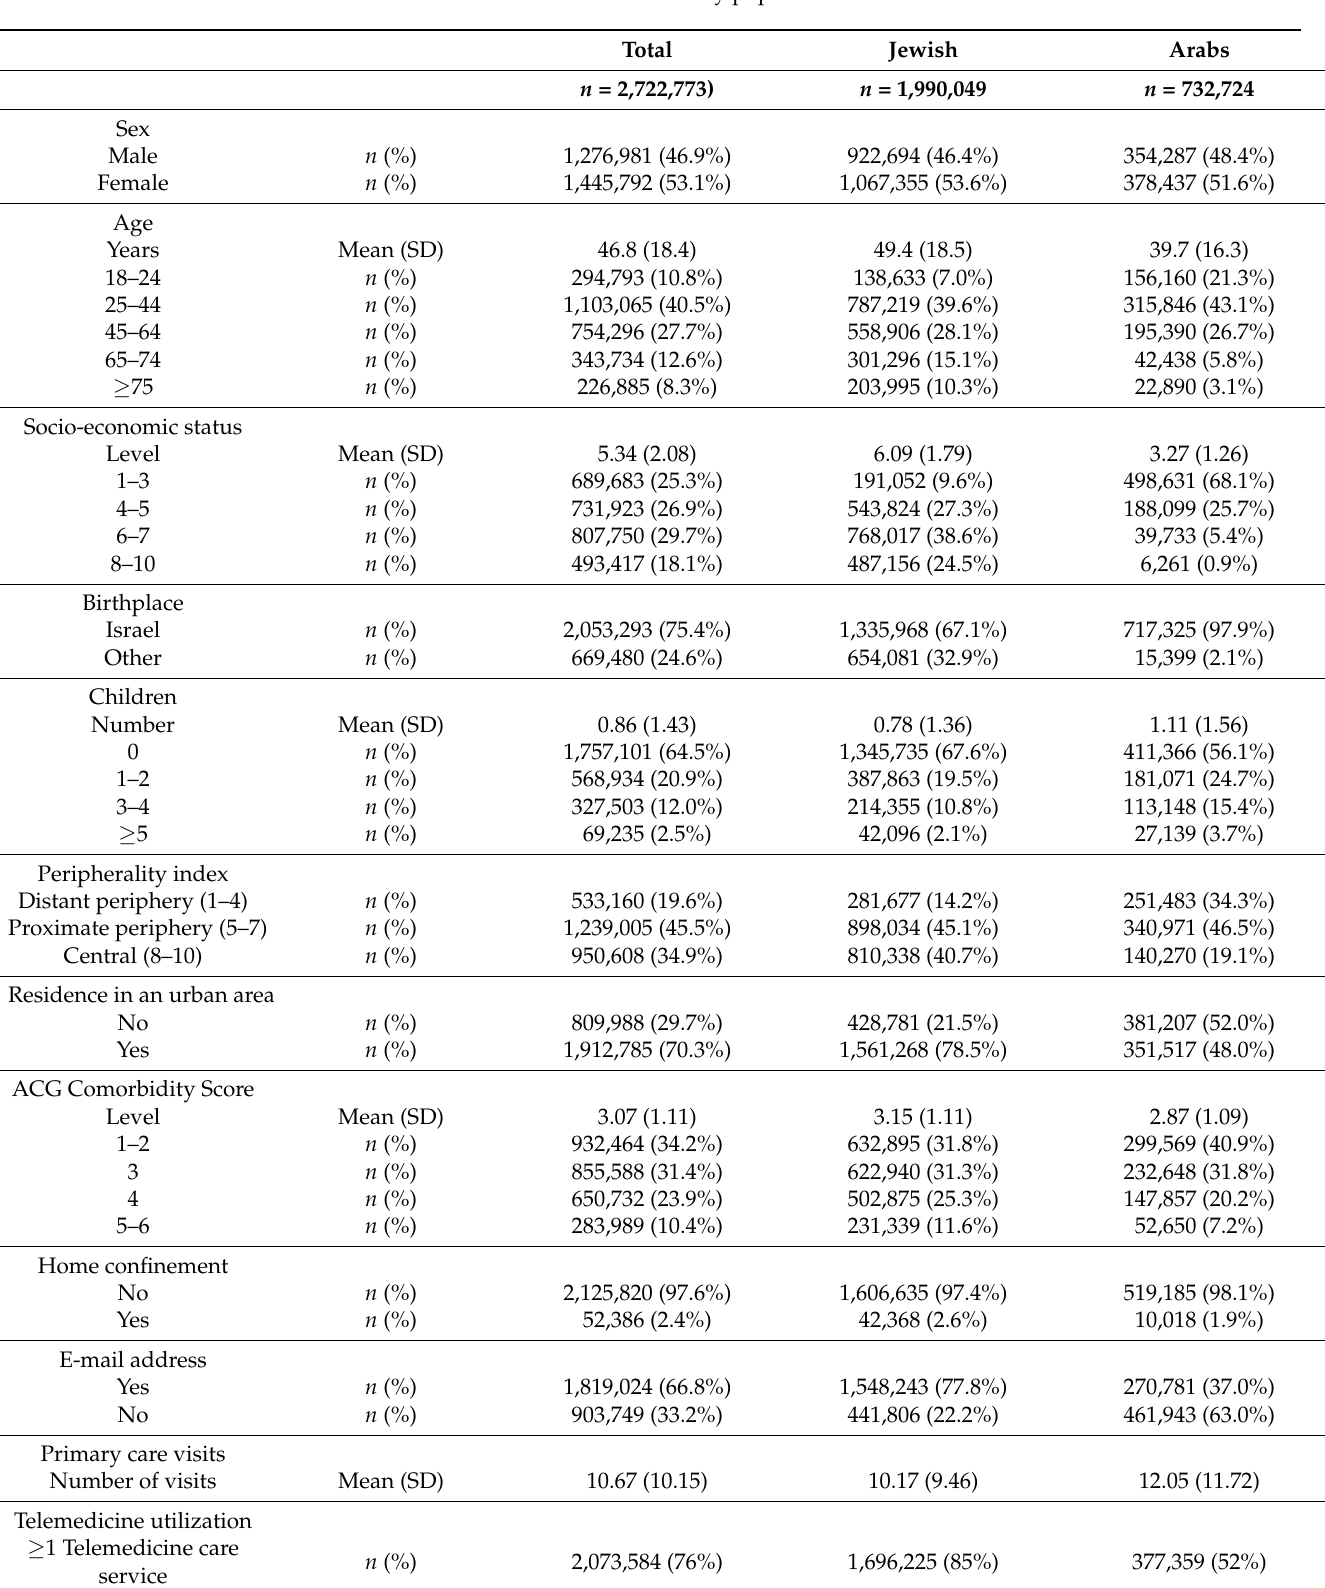
Table 1. Main characteristics of the study